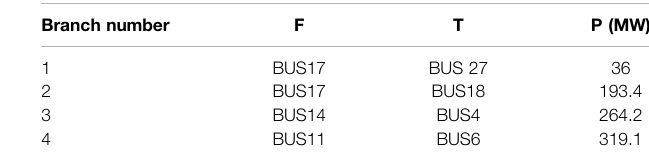
TABLE 1 | Power fl ow distribution of section